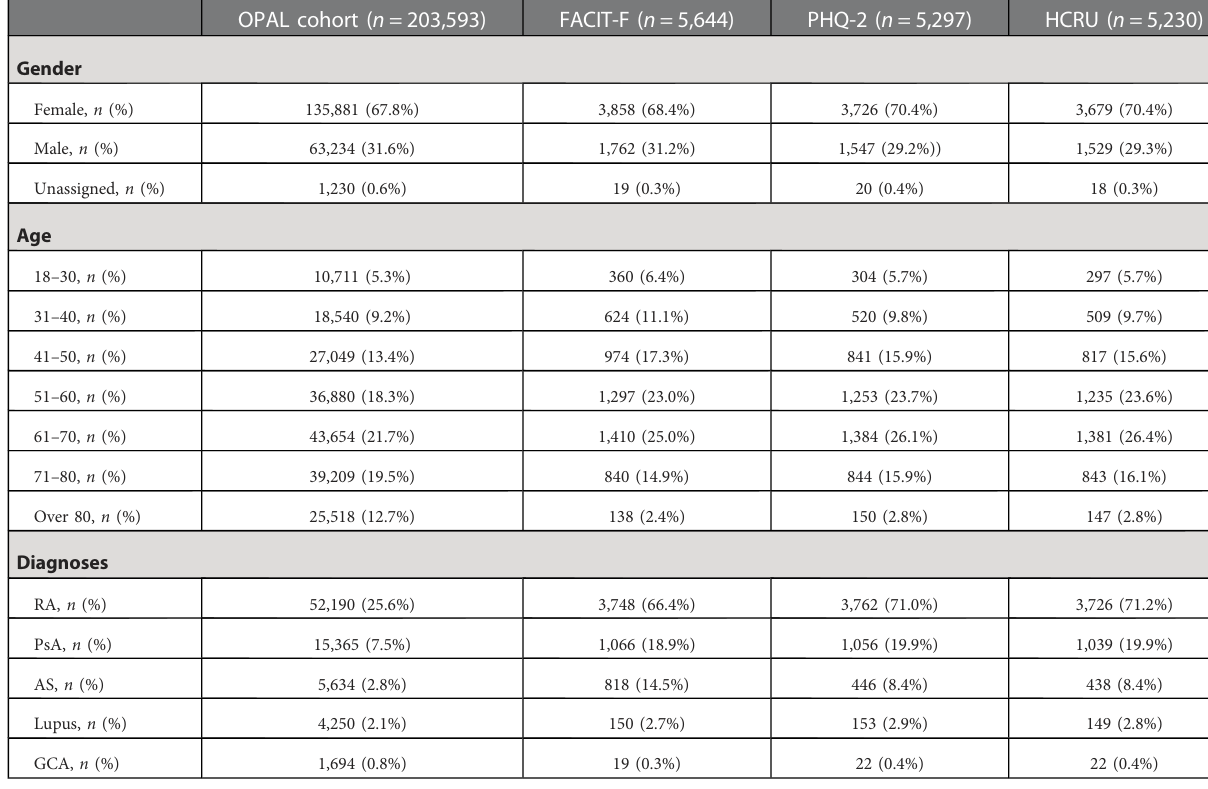
TABLE 1 Demographic and clinical features of patients in the total OPAL cohort and patients in each PRO dataset.